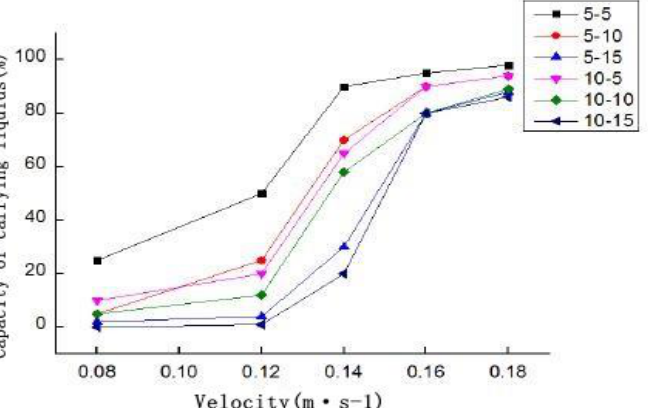
Figure 10. Relation between capacity of carrying liquids and dip angle; Black line: up-dip angle of 5 ◦ , down-dip angle of 5 ◦ ; Red line: up-dip angle of 10 ◦ , down-dip angle of 5 ◦ ; Blue line: up-dip angle of 15 ◦ , down-dip angle of 5 ◦ ; Pink line: up-dip angle of 5 ◦ , down-dip angle of 10 ◦ ; Green line: up-dip angle of 10 ◦ , down-dip angle of 10 ◦ ; Purple line: up-dip angle of 15 ◦ , down-dip angle of 10 ◦